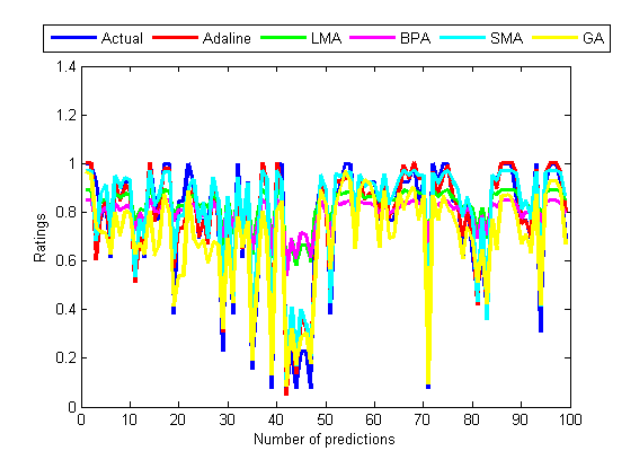
Figure 5. Graph of actual ratings and the predicted ratings of the experimented algorithms.